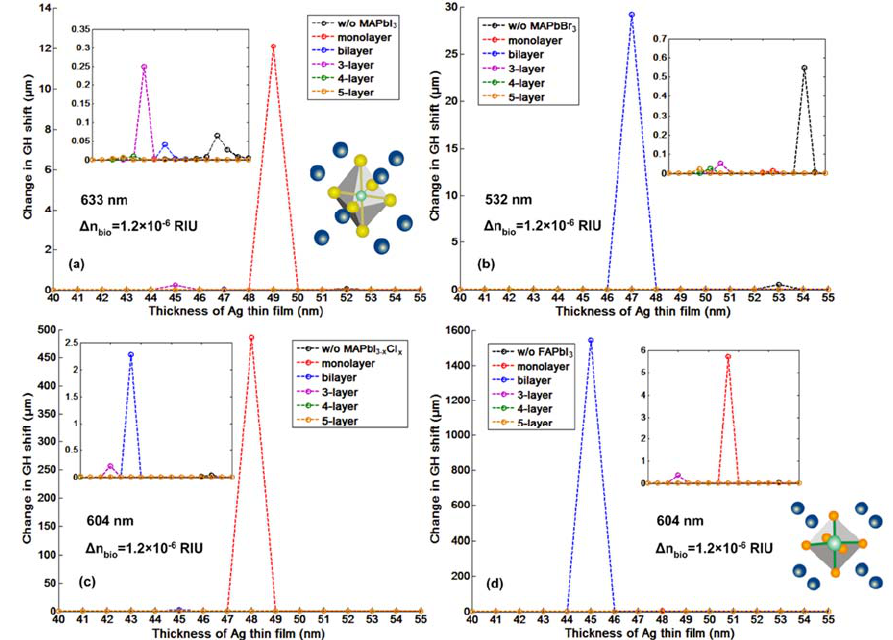
Figure 5. Goos–Hänchen (GH) ‐ SPR signal changes enhanced by four different types of 2D perovskites ranging from ( a ) MAPbI 3 , ( b ) MAPbBr 3 , ( c ) MAPbI 3 − x Cl x to ( d ) FAPbI 3 , which are respectively tuned by different silver substrate thickness. The refractive index change for the targeted sample solutions is fixed to a narrow change of 10 –6 RIU.